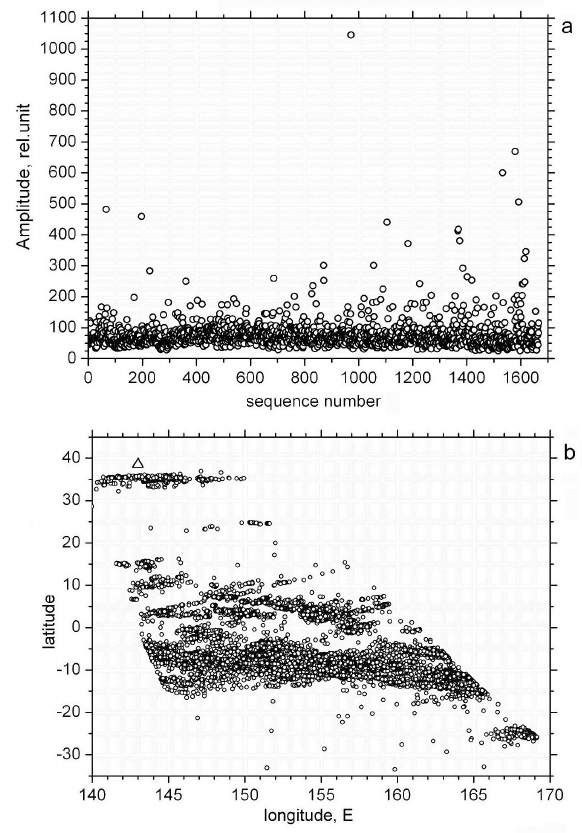
Fig. 1. (a) the behavior of AA during the time interval of 02:00– 03:00 UT for 1–14 March 2011 (from the azimuthal sector ± 10 de- grees relative to the direction to the EQ epicenter); (b) the spatial distribution of lightning discharges in the maximum of thunder- storm activity (15:00–18:00 LT) on the day of the strongest EQ (11 March 2011) by the network WWLLN data ( 1 is a epicenter of M = 9 Tohoku